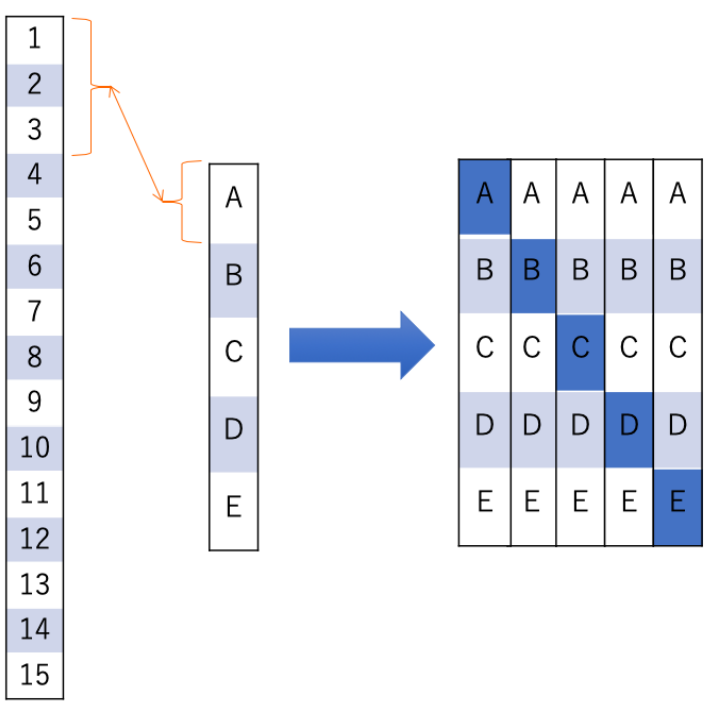
Figure 5. Procedure of the five-fold cross-validation. First, for each of five groups (group A to E), three subjects were randomly selected from among 15 subjects. Using the five-fold cross-validation approach, these five groups were further divided into a training group (consisting of four groups) for deep learning (DL) and a validation group (shown in dark blue above). The process was repeated so that each of the groups was used in DL. Table 1. Correspondence table for calculating the identification rate.